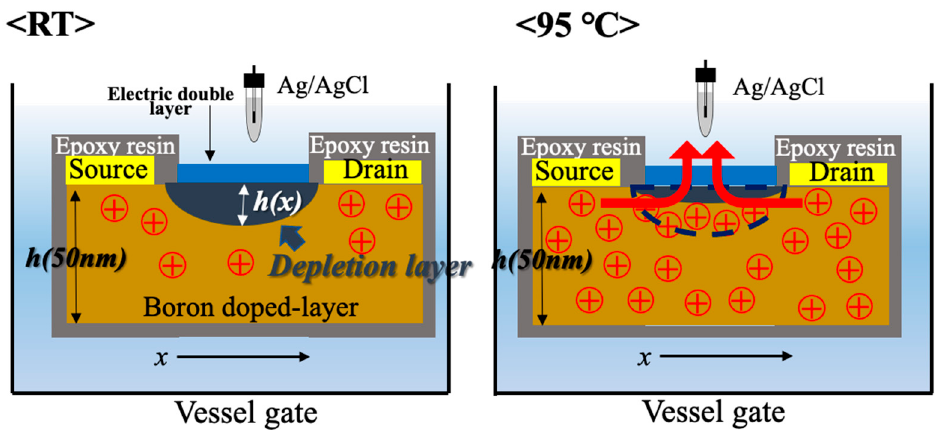
Figure 3. The state of the depletion layer of the C-O BDD SGFETs when the drain-source voltage is low and the gate leakage current is flowing. At 95 ◦ C, when the drain-source voltage is small, the depletion layer is not sufficiently formed and a gate leakage current is generated.